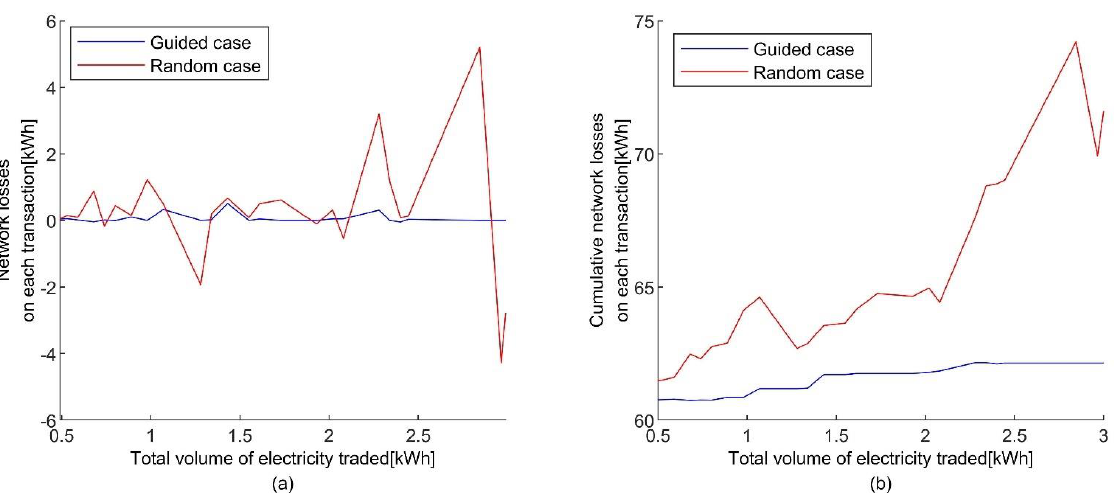
Figure 10. Network losses on each transaction with 5 kWh transaction limit in the IEEE 33 bus case: ( a ) network losses on each transaction; ( b ) cumulative network losses on each transaction.